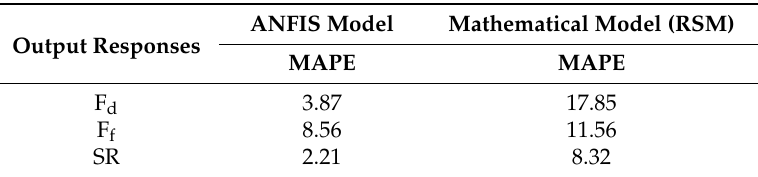
Table 9. Comparison of the developed models.